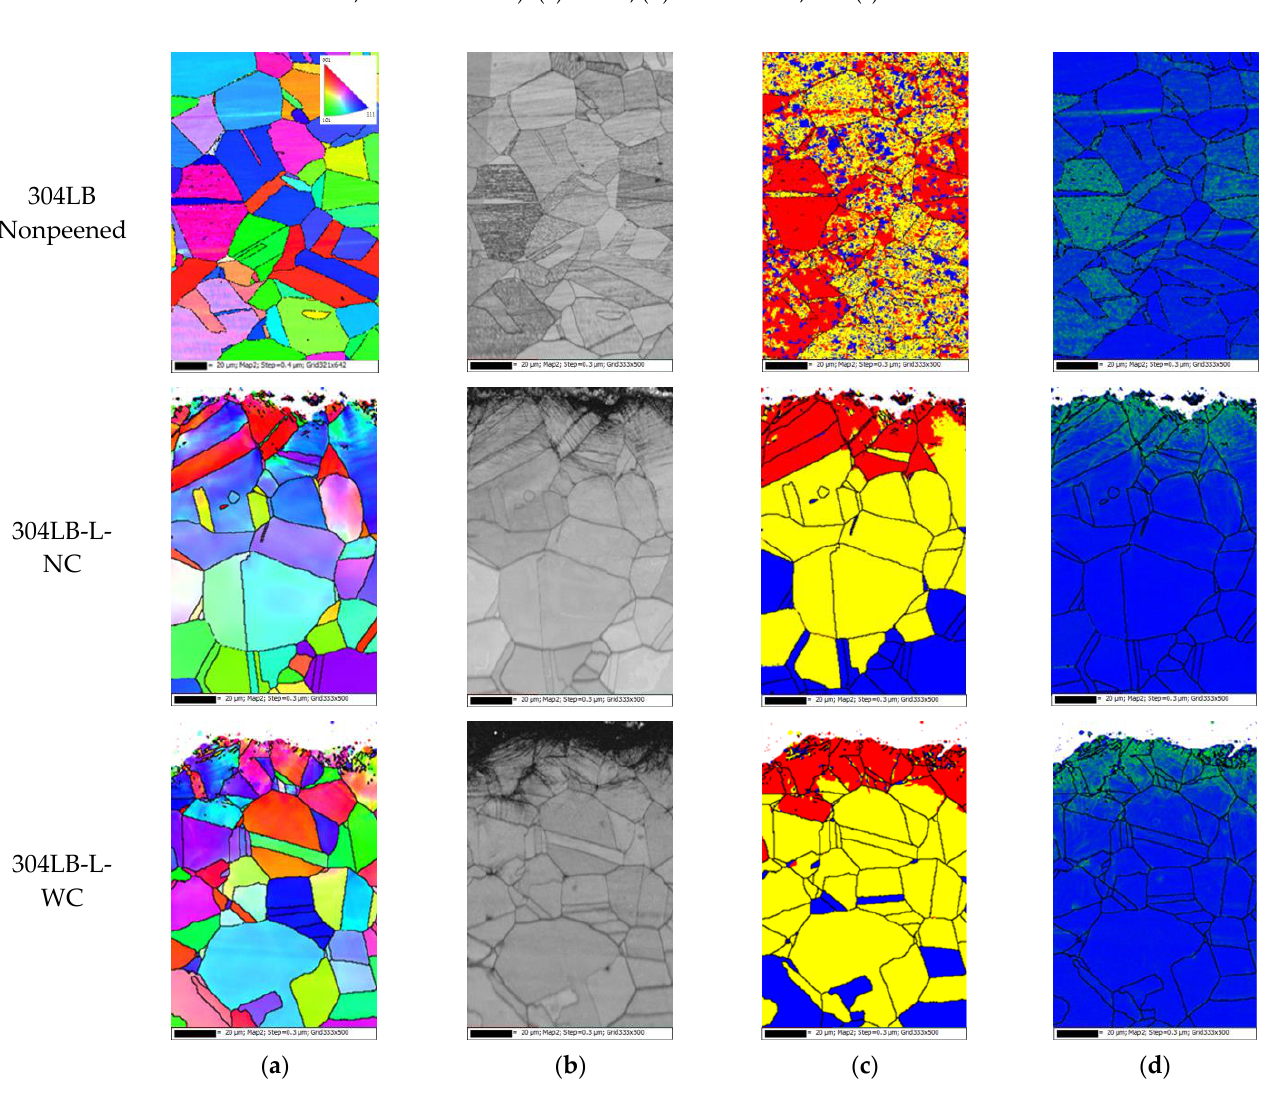
Figure 10. EBSD results of 304L base metal after laser peening (EBSD: step size 0.3 μm, depth ~150 μm) : ( a ) IPF coloring, ( b ) band contrast, ( c ) recrystallized fraction, and ( d ) dislocation density.